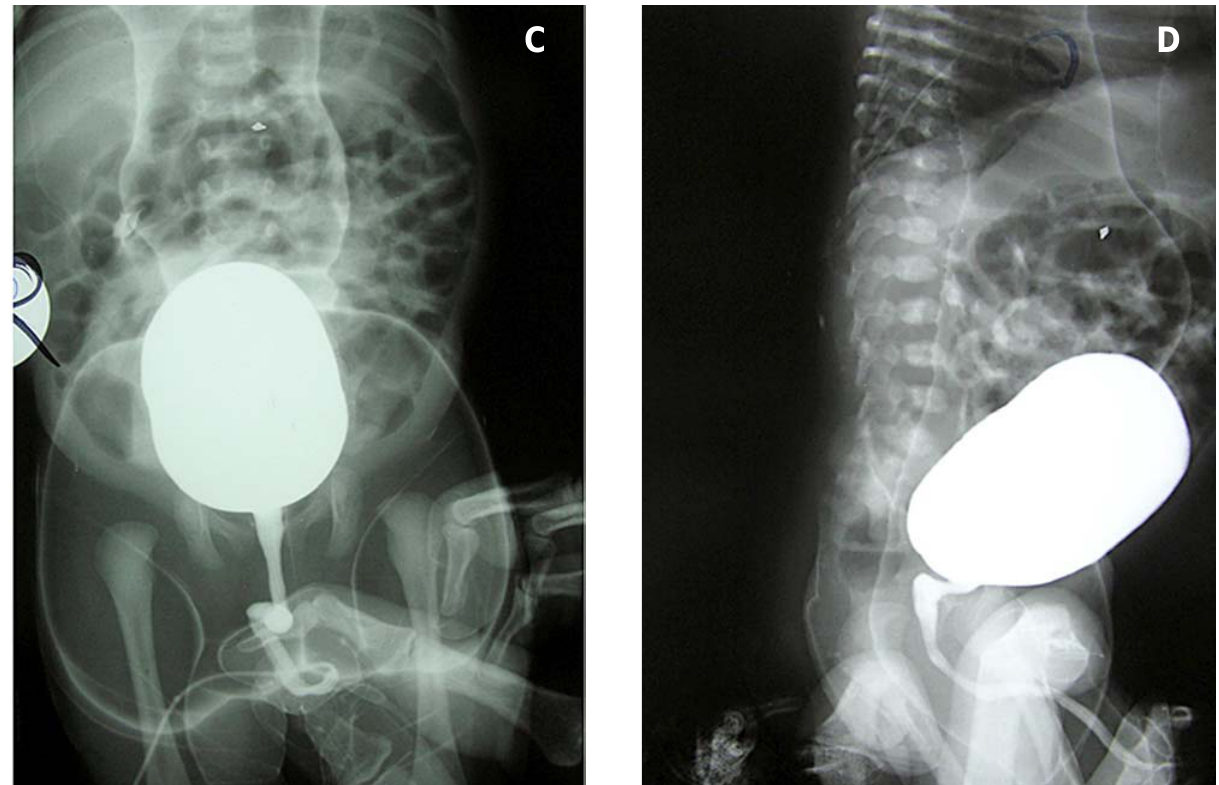
Figure1 – Voiding cystourethrography of case #1. C) and D) Frontal and lateral voiding cystourethrography views of the same patient after surgical